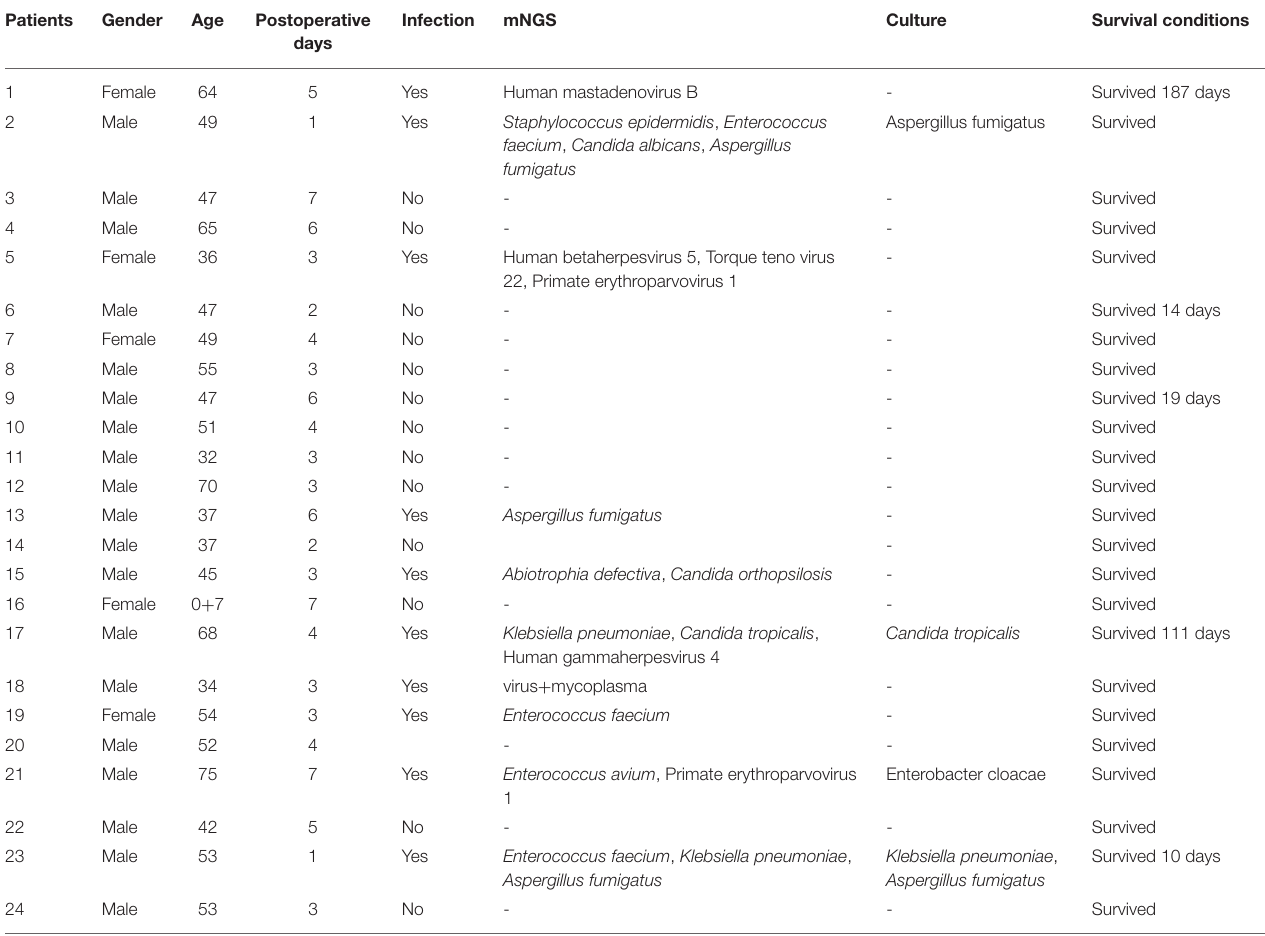
TABLE 1 | Infection and survival data of patients 1 week after liver transplantation in this study.